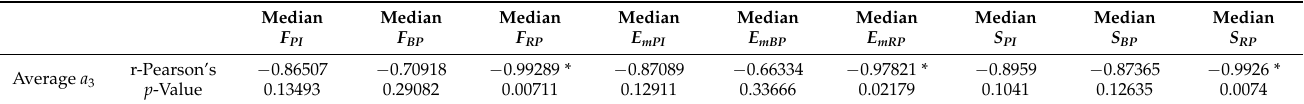
Table 7. Results of analysis of the correlation between grain thickness and medians of cumulated probability distributions of the analyzed mechanical properties of maize grains, * means significant correlations for which p < 0.05.